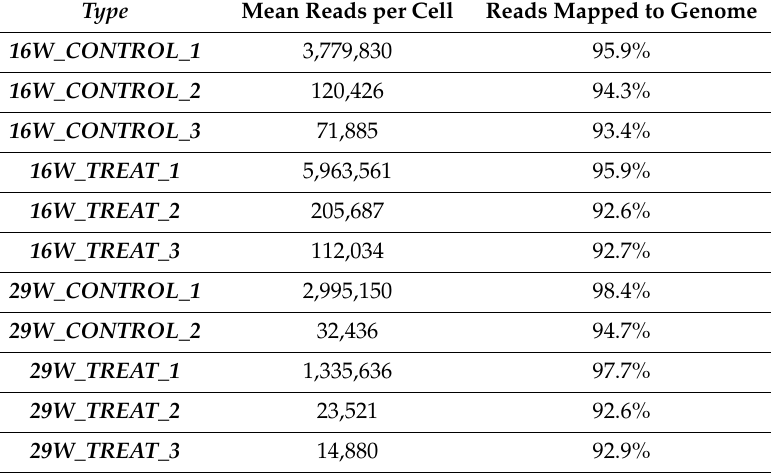
Table 1. Next-generation sequencing mapping results of the mouse genome (mm10) in the control and experimental